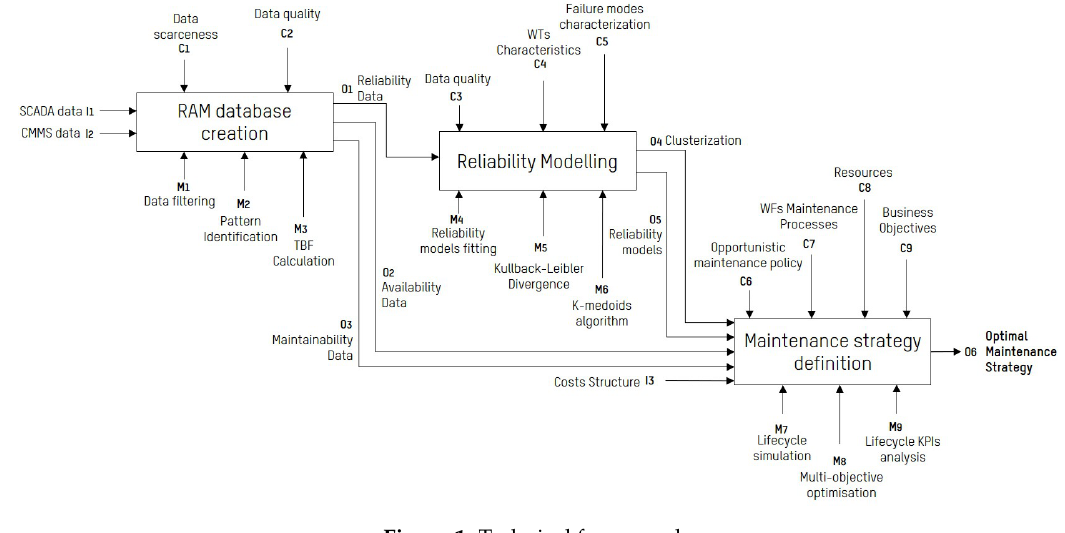
Figure 1. Technical